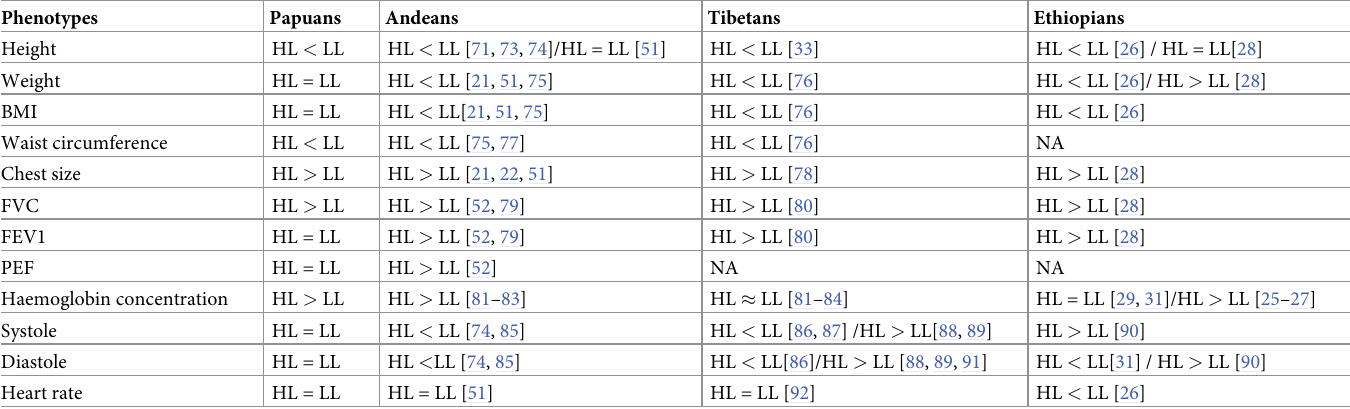
Table 2. Variation in phenotypic traits between highlander and lowlander native groups.